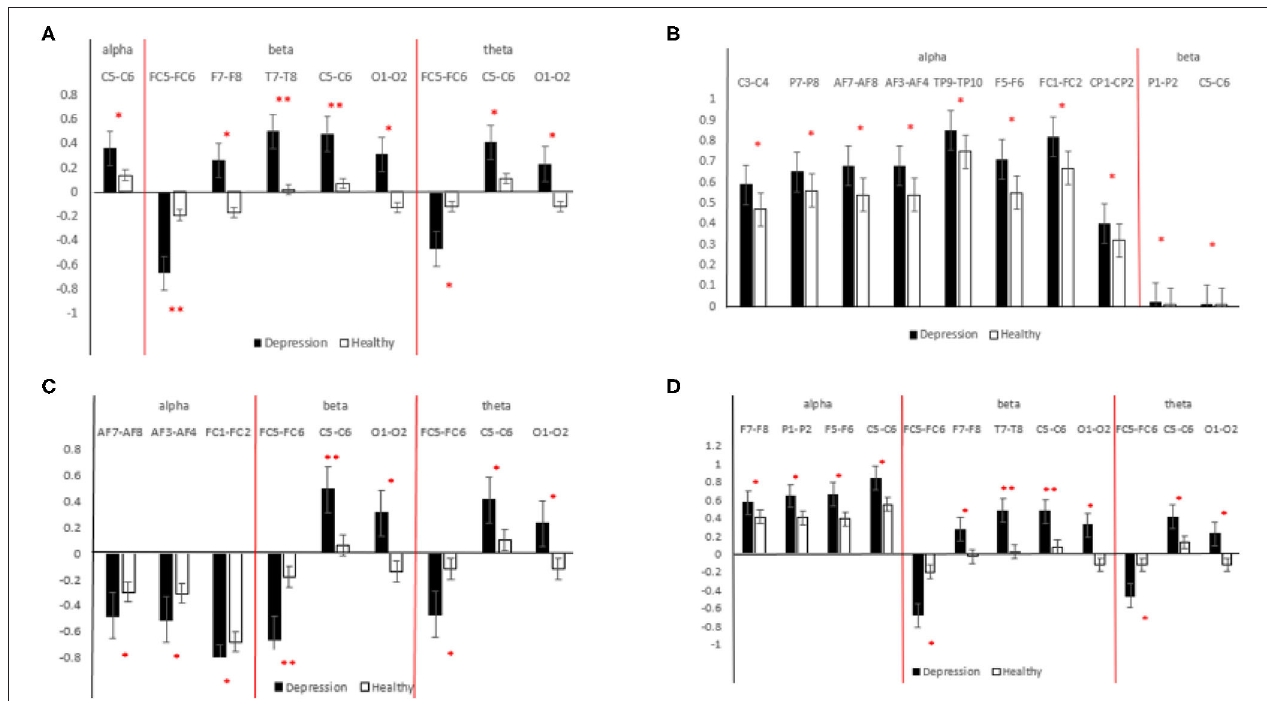
FIGURE 6 | Statistical analysis results for different features [ (A) interhemispheric asymmetry; (B) cross-correlation; (C) MIX1; (D) MIX2]. The black bar indicates the MDD group, and the white bar indicates the HCs. **indicates 0.001 < p < 0.01, *indicates 0.01 < p < 0.05.